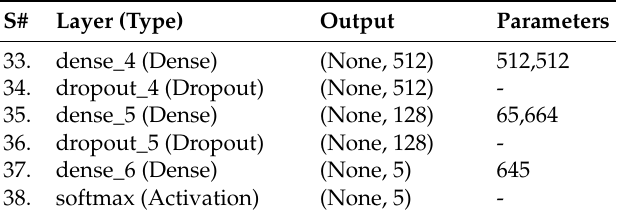
Table 2. Transfer Learning - Layer